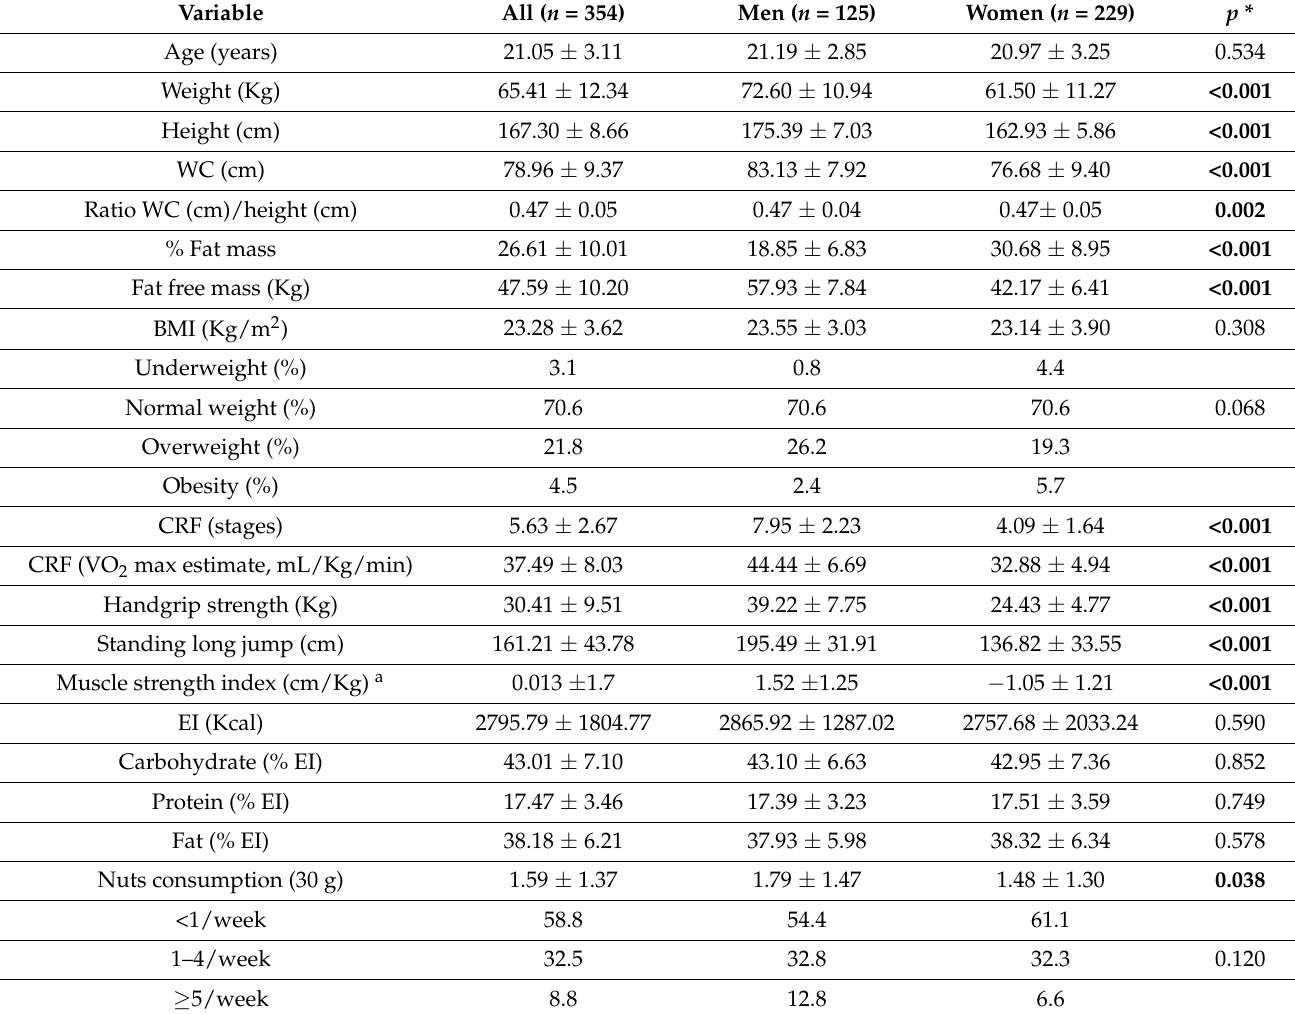
Table 1. Descriptive characteristics of the study sample by